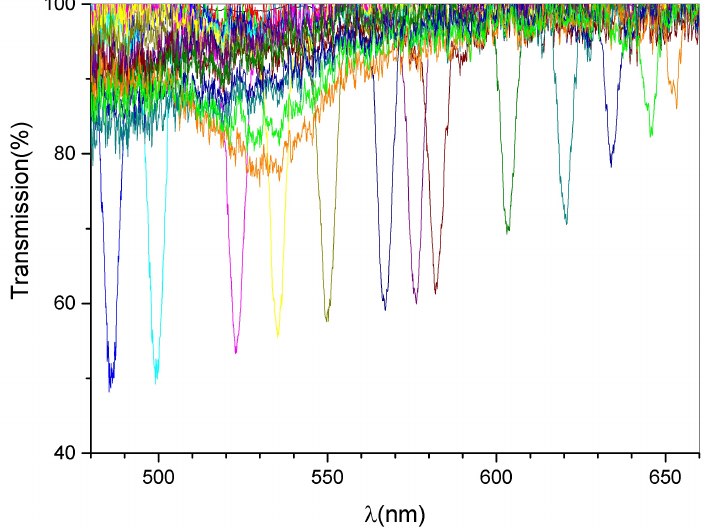
Figure 4. Typical transmission spectra as a function of the external rotation angles. The reflection peaks show a FWHM of ≈ 8 nm.